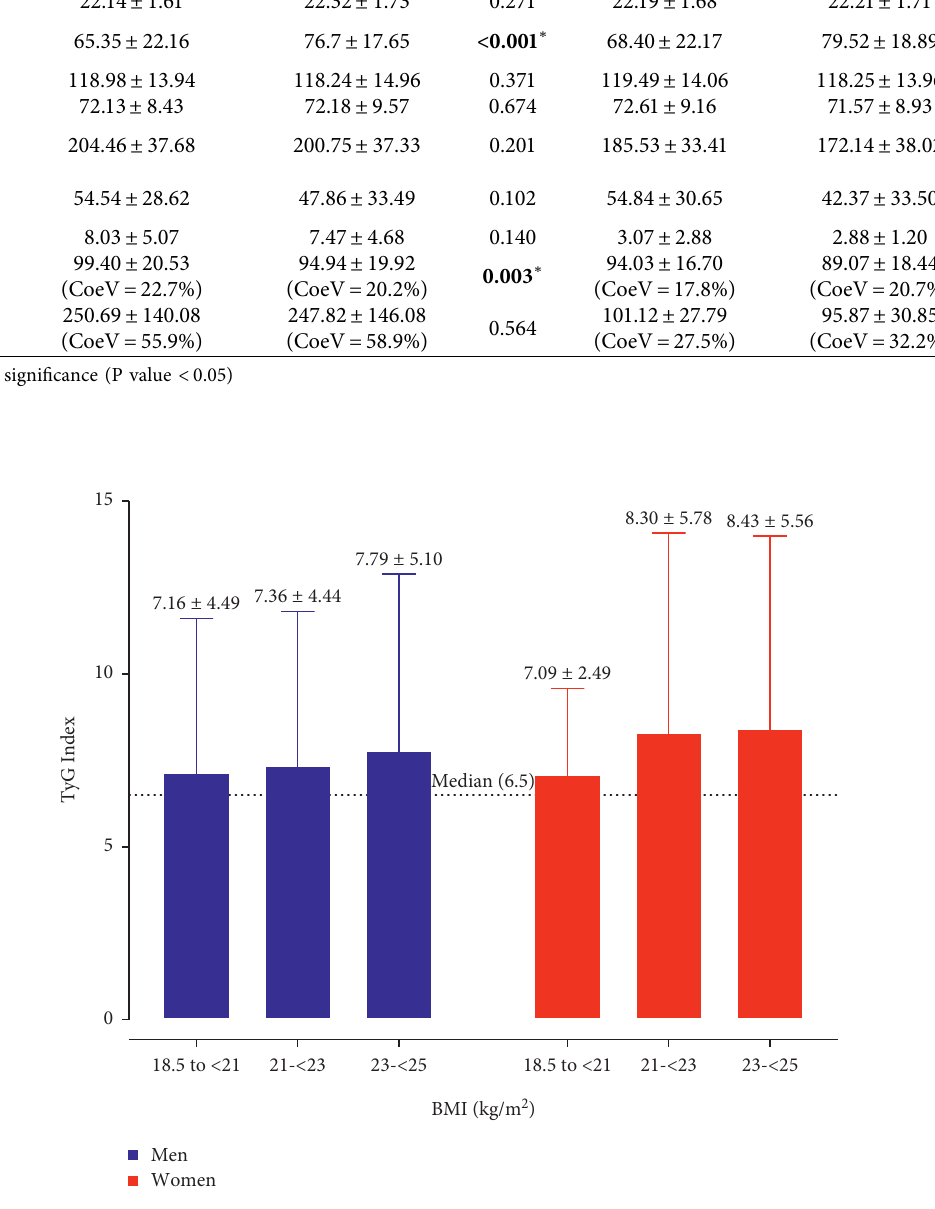
Figure 1: Sex differences in the TyG index among metabolically obese normal weight Table 2: Sex differences in the Spearman correlation between TyG index and cardiovascular risk factors.